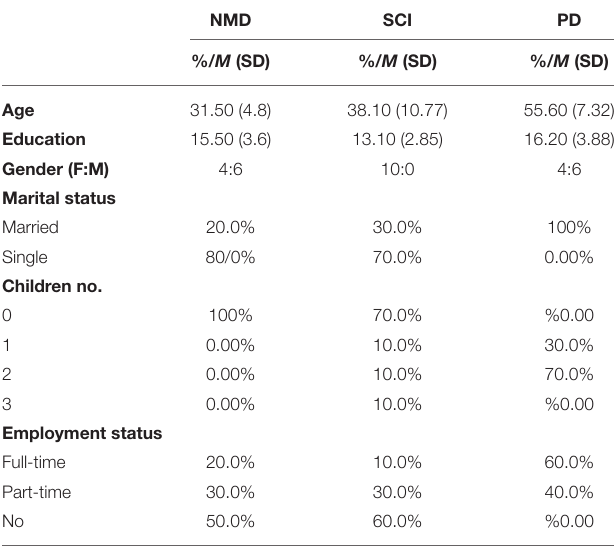
TABLE 1 | Demographic characteristics of the NMD, SCI, and PD participants ( n =